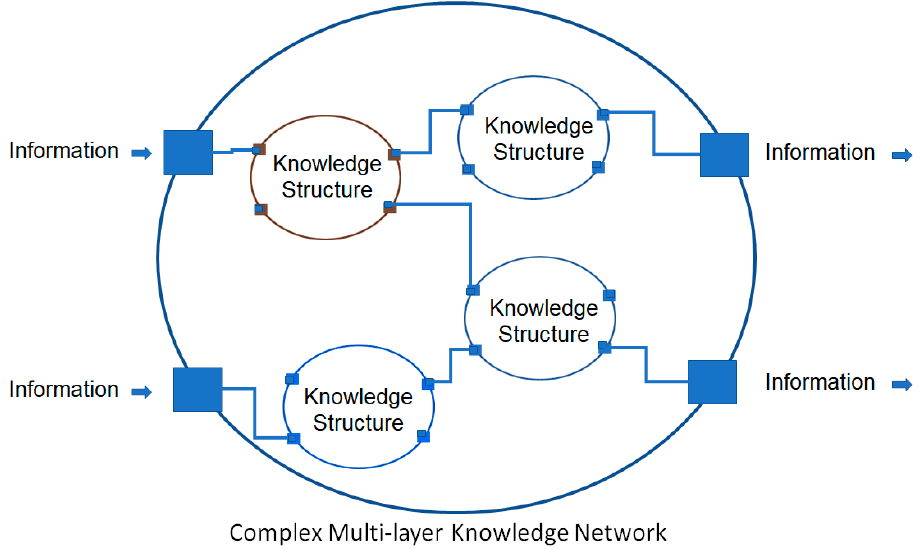
Figure 2. A knowledge network specifying the knowledge structures where information is communicated between nodes through barrios links. The nodes define the structure and function of the domain knowledge in the form of named sets.